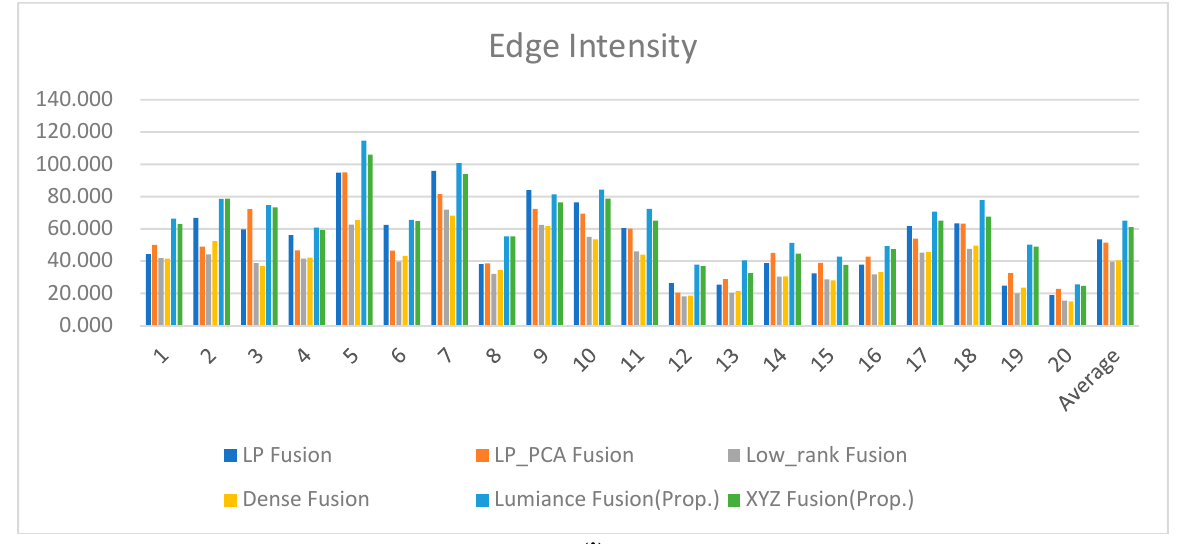
Figure 16. Metric scores: ( a ) BRISQUE score; ( b ) VIFF score; ( c ) Entropy score; ( d ) Cross entropy score; ( e ) CPBD score; ( f ) S3 score; ( g ) Spatial frequency score; ( h ) Average gradient score; and ( i ) Edge intensity score.